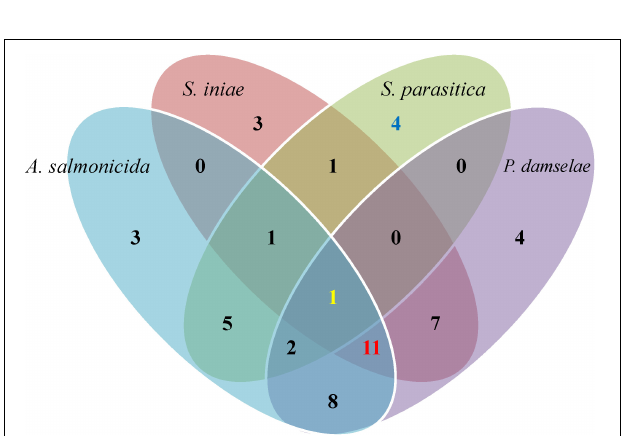
the freshwater algae Pithophora spp. and Leptolyngbya sp.